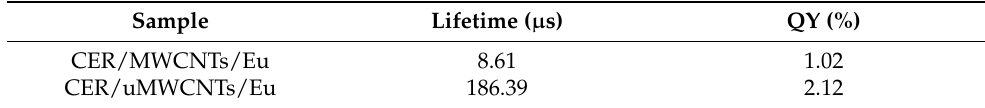
Table 3. The lifetime and quantum yield (QY) of CER/MWCNTs/Eu and CER/uMWCNTs/Eu